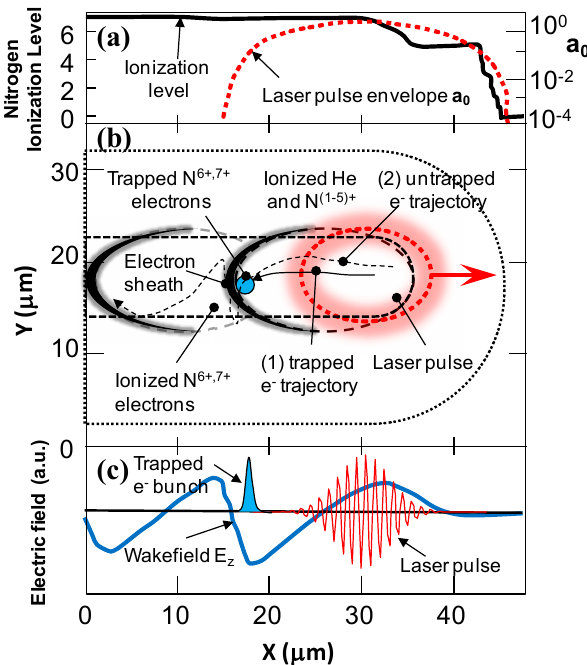
Figure 4. A physical process for tunnel ionization in shown in a He and N 2 mixed gas, wakefield excitation, electron trapping due to ionization-induced injection mechanism, and acceleration in wakefields, schematically illustrated from particle-in-cell simulation results carried out by Pak et al. [26]. ( a ) The envelope of the normalized vector potential a 0 of the laser (dashed line) and the ionization state of nitrogen atoms (solid line) on axis; ( b ) Electron-density distribution from He and the L -shell electrons of nitrogen (inside dotted line) and from the K -shell electrons of nitrogen (inside dashed line), where electron (1) is ionized close to the axis and is trapped by the wakefield, while electron (2), ionized earlier and off-axis, slips and is not trapped; ( c ) The electric field of the laser pulse, the longitudinal electric field of the wake E z , and the accelerated electron